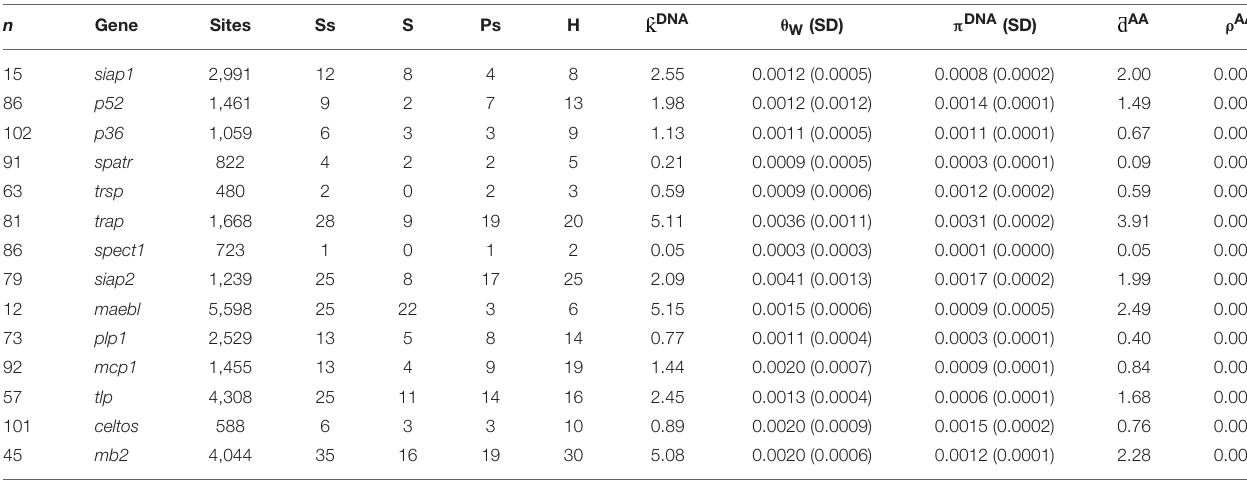
TABLE 2 | Estimating 14 P. vivax sporozoite genes’ genetic